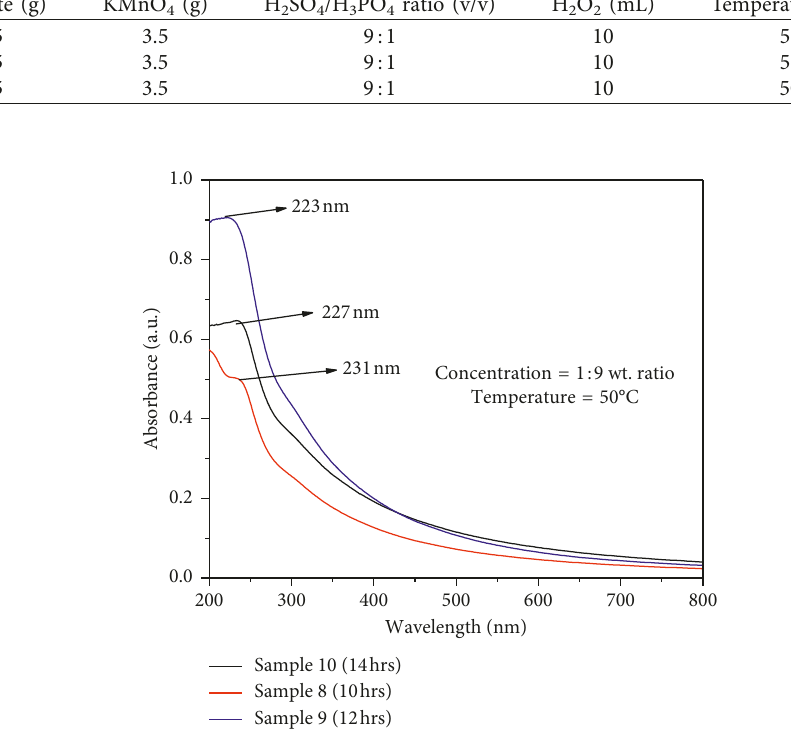
Figure 3: UV-Vis spectra at different time